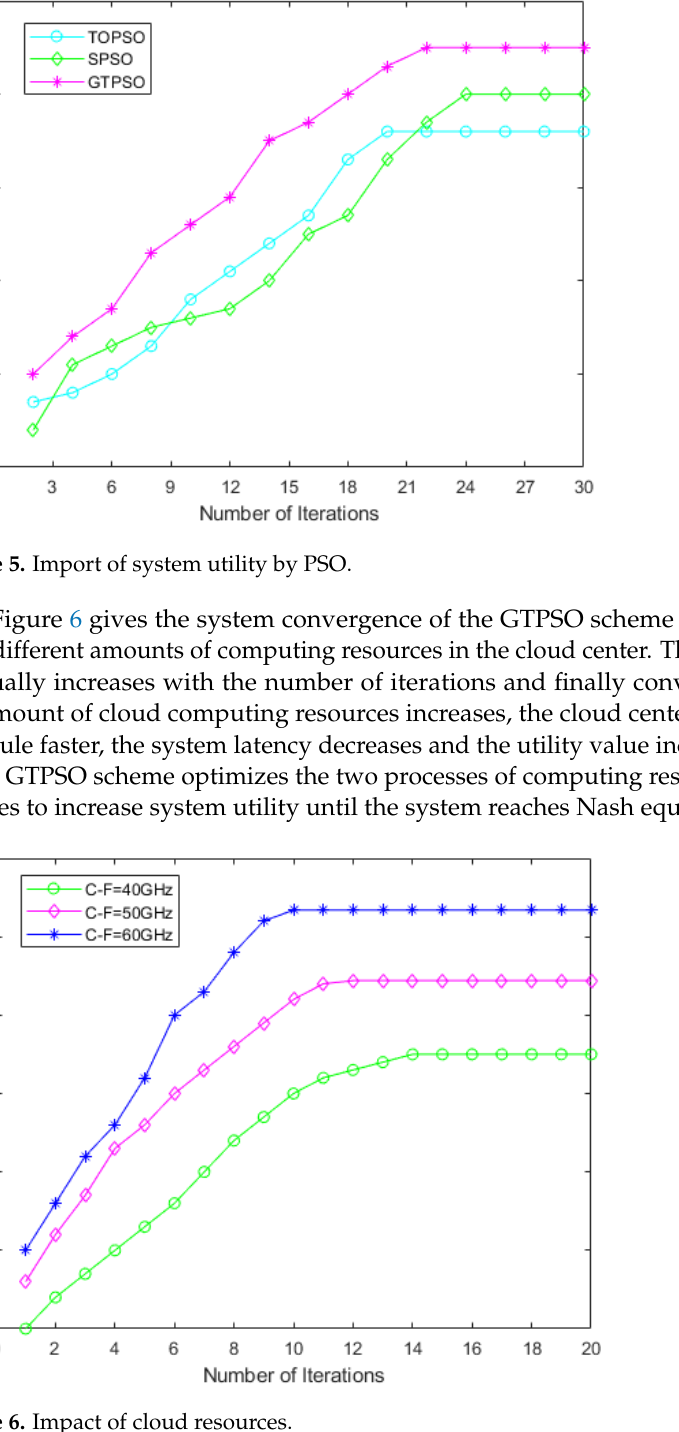
Figure 6. Impact of cloud resources.